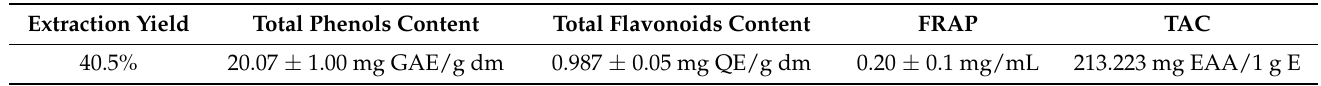
Table 1. Determination of total phenols and flavonoids contents, and antioxidant activity of the hydroethanolic extract from Rosa damascena flowers.